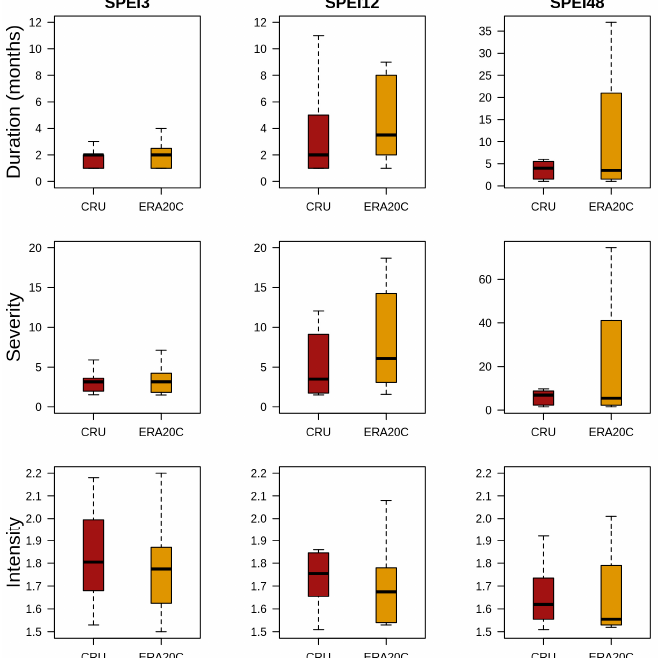
Figure 2. SPEI for 3-( a , d ), 12-( b , e ) and 48-month ( c , f ) timescales for the city of Sao Paulo in the period 1933-2010. ( a , b , c ) IAG weather station; ( d , e , f ) ERA20C reanalysis; ( g , h , I ) CRU. Red (blue) regions in the graph represent negative (positive) SPEI values. The solid line marks the threshold SPEI = -1.5.